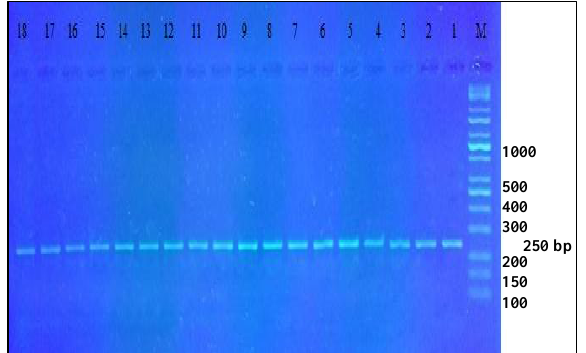
Figure, 1: The product was electrophoresis on 2% agarose gel at 5 volt/cm 2 , 1x TBE buffer for 2 hours. M: DNA ladder (100-10000bp), lane (1-18) PCR product of band size 240bp. visualized under U.V light after staining with red stain safe.